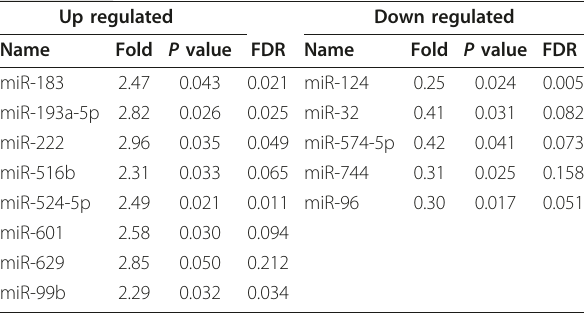
Table 2 miRNAs differentially expressed with vs.